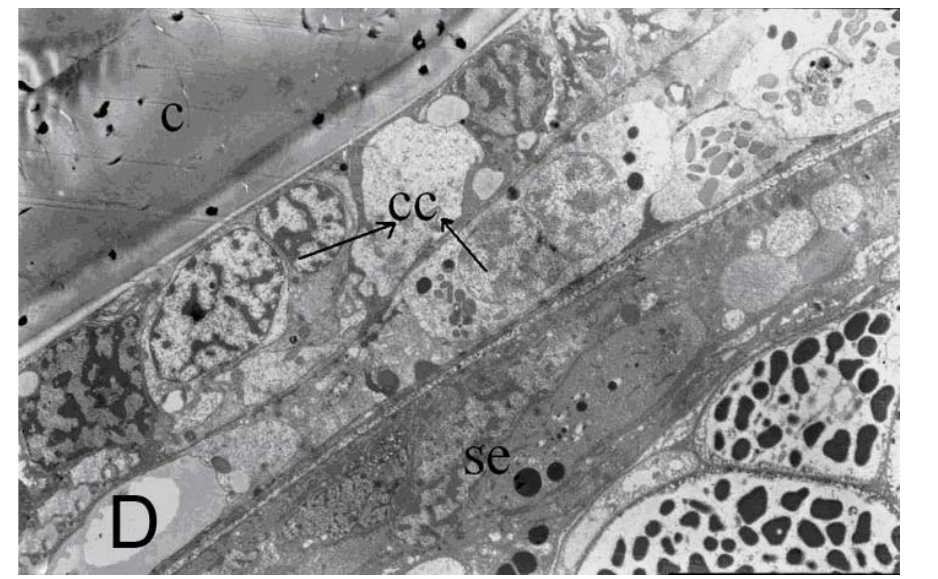
Figure 1. ( A ) General view of transverse section of E. mingrelicus ’s telson consisting of a pair of venom glands. The two glands were segregated within the telson by gross striated muscle bundles; the outer surfaces of venom glands are covered by cuticle. ( B ) One of the venom glands. Muscle bundles converge to regions where the venom glands contact telson cuticle. Cuticle (c), muscle tissue (m), secretory epithelium (se) and secretion granules are visible (167x). ( C ) The telson cuticle consists of exocuticle that is a homogeneous layer and endocuticle composed of lamellar layers. There are some hemolymph vessels and cuticle canals in the endocuticle. The cytoplasm of glandular epithelium is filled with many secretory granules of different sizes, shapes and densities. ( D ) In the region where cuticle and gland merge, there are two layers of cuboidal cells (cc) between cuticle (c) and glandular epithelium (se)